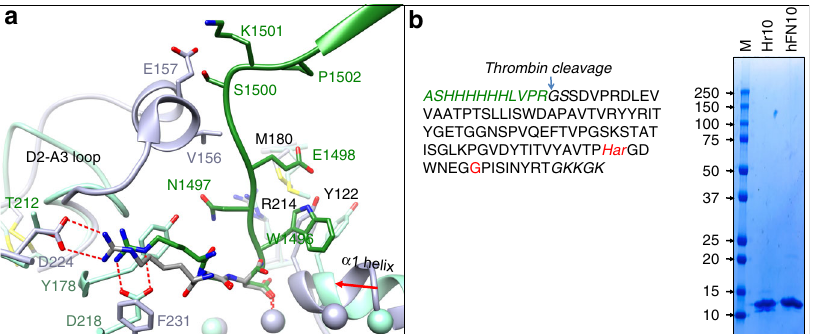
Fig. 1 Structure-guided design and binding properties of Hr10. a Ribbon diagrams of the crystal structures of α V β 3/hFN10 (light green, 4mmz.pdb) and α IIb β 3/epti fi batide (light purple, 2vdn.pdb) superposed on the respective β A domains, with the metal ions at the ligand-associated metal-binding site (LIMBS), MIDAS, and adjacent to MIDAS (ADMIDAS) shown as spheres in the respective colors. Relevant segments of the propeller and β A domains and of hFN10 (dark green) and epti fi batide (dark gray) are shown. The MIDAS ion is ligated by the aspartate residue from each ligand. Residues (single letter code) speci fi c to each structure are shown in the respective color, with residues or loops common in both shown in black. Oxygen, nitrogen, and sulfur atoms are in red, blue, and yellow, respectively. The inward movement (red arrow) of the α 1 helix and ADMIDAS ion in α IIb β 3, driven by binding of the partial agonist epti fi batide, is absent in hFN10-bound α V β 3, the result of a π – π interaction between hFN10-W 1496 and β A-Y 122 . β A-R 214 and β A-M 180 contribute to the stability of hFN10-W 1496 . Epti fi batide-Har 2 forms a bidentate salt bridge with α IIb-D 224 , whereas hFN10-R 1493 contacts α V-D 218 (replaced by F 231 in α IIb). b The translated sequence of His-tagged Hr10 lacking the N-terminal methionine. Har and glycine substitutions are indicated in red. Alien residues are in italics (green text). The isotopically averaged calculated molecular weight of Hr10 was 11,969.3 (protein calculator v3.4 http:// protcalc.sourceforge.net/cgi-bin/protcalc). Inset, Coomassie stain of a whole 10 – 20% SDS – PAGE showing puri fi ed Hr10 and hFN10 (8 μ g in each lane). MW markers (in kDa) are